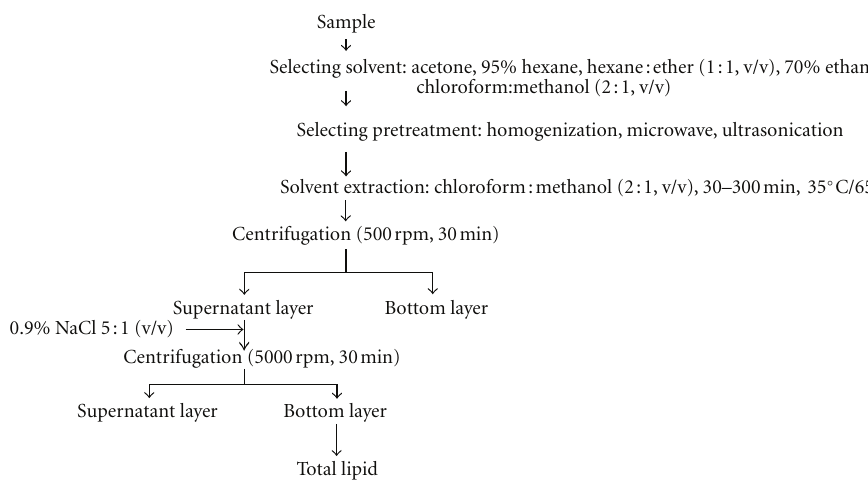
Figure 1: A flow diagram of lipid extraction from Scenedesmus